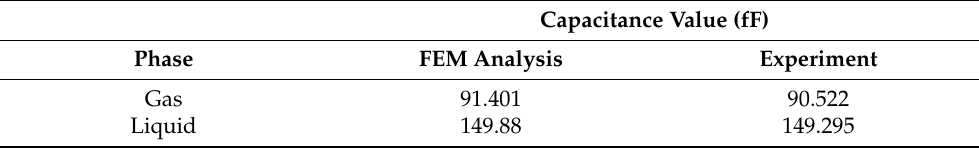
Table 3. Single-phase validation